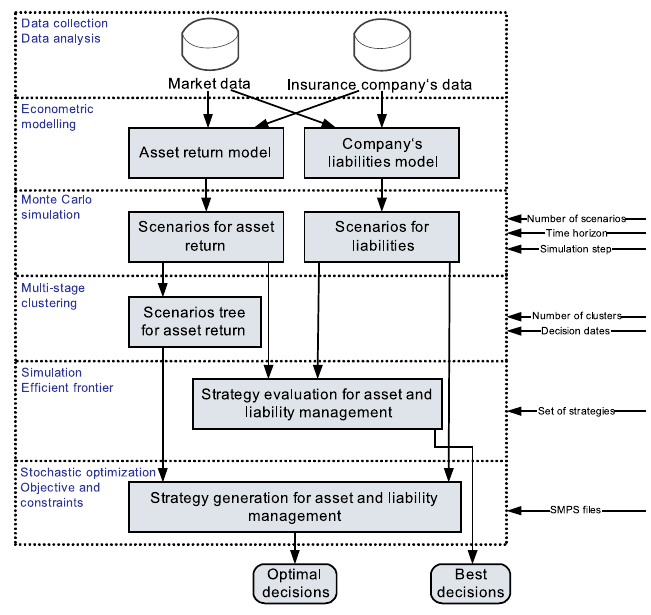
Fig. 8. Structural scheme of insurance company management